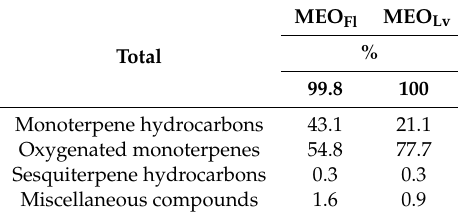
Table 3. Summary of the chemical compositions of MEO Fl and MEO Lv